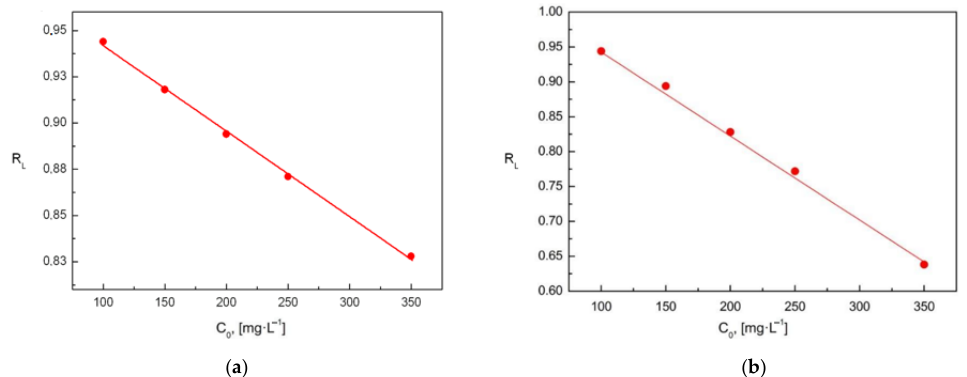
Figure 8. Dependence of the equilibrium parameter R L on the initial concentration of: ( a ) chromates ions and ( b ) phosphates ions in aqueous solutions for the Langmuir isotherm. The Langmuir maximal adsorption capacity of Absodan Plus converted to phospho-